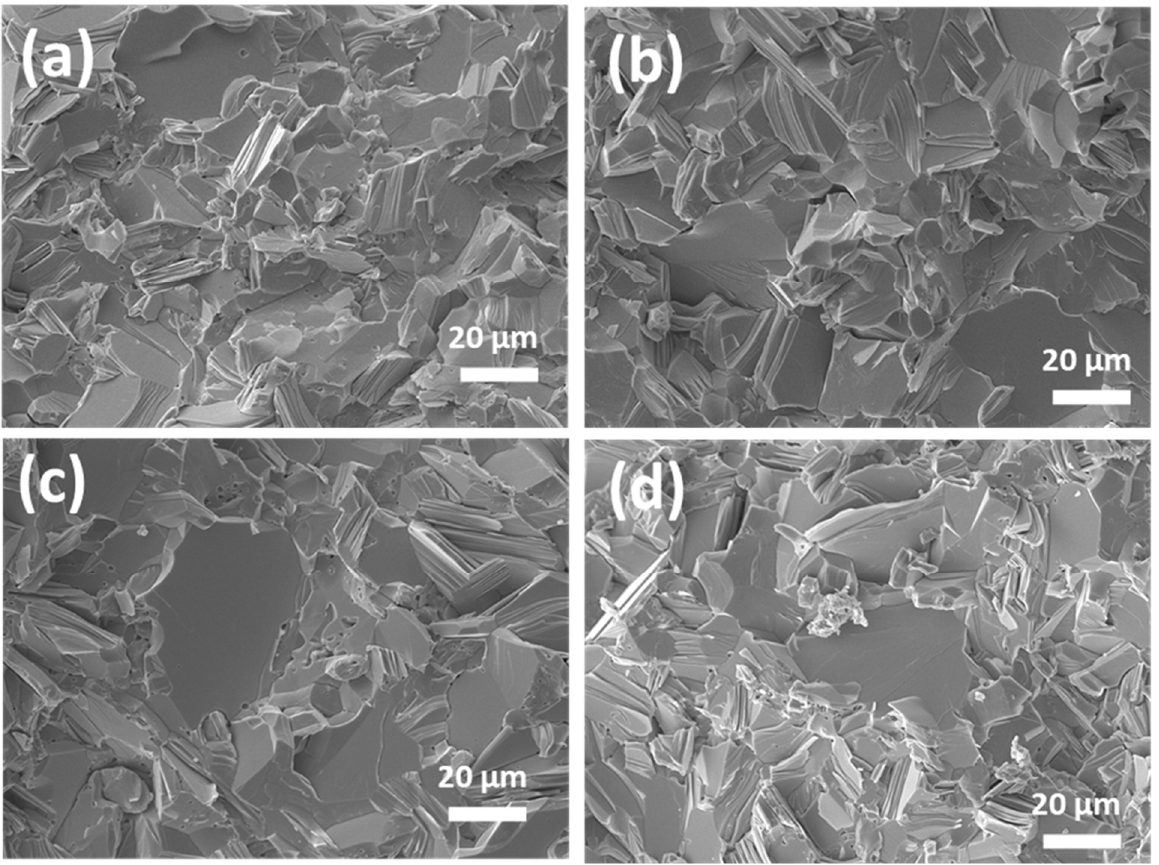
Figure 3. SEM bulk fracture surface analysis of different powder ranges of p-type Cu 0.07 Bi 0.5 Sb 1.5 Te 3 bulk specimens ( a ) 32–75 μm, ( b ) 75–125 μm, ( c ) 125–200 μm, and ( d ) <200 μm samples.